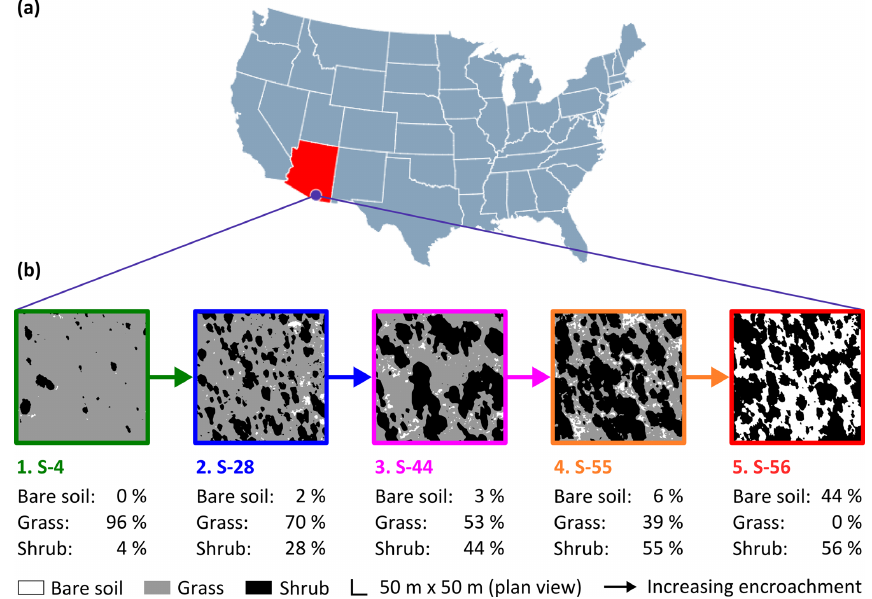
Figure 1. The study site (a) was a semi-arid grassland in the Santa Rita Experimental Range, AZ, US (31 ◦ 54 (cid:48) N, 110 ◦ 53 (cid:48) W; elevation: ∼ 1250ma.s.l.). Five sampling sites comprised a gradient of shrub encroachment, where grass cover decreased and bare soil and shrub cover increased between sites 1 and 5 (b) . The inter-shrub area of each site is equal to the sum of the percentage of bare soil and grass cover.